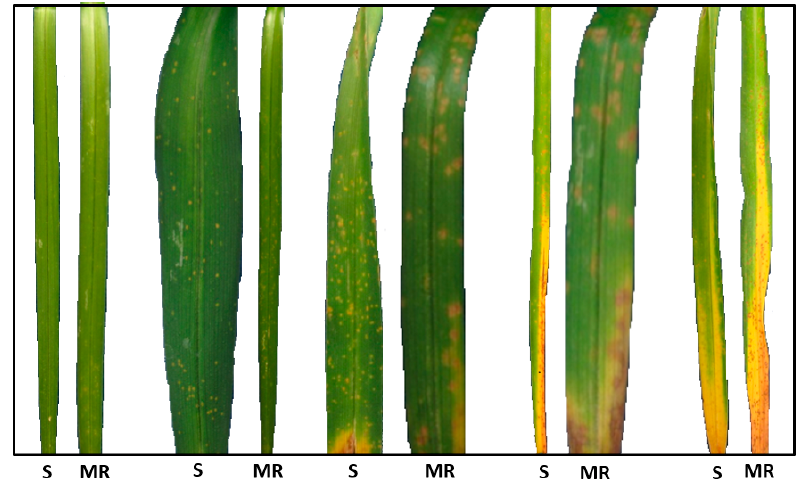
Figure 7. Comparison of diseased leaf area of rust ( Puccinia hemerocallidis ) in leaves of susceptible (S) and moderately resistant (MR) Hemerocallis cultivars.